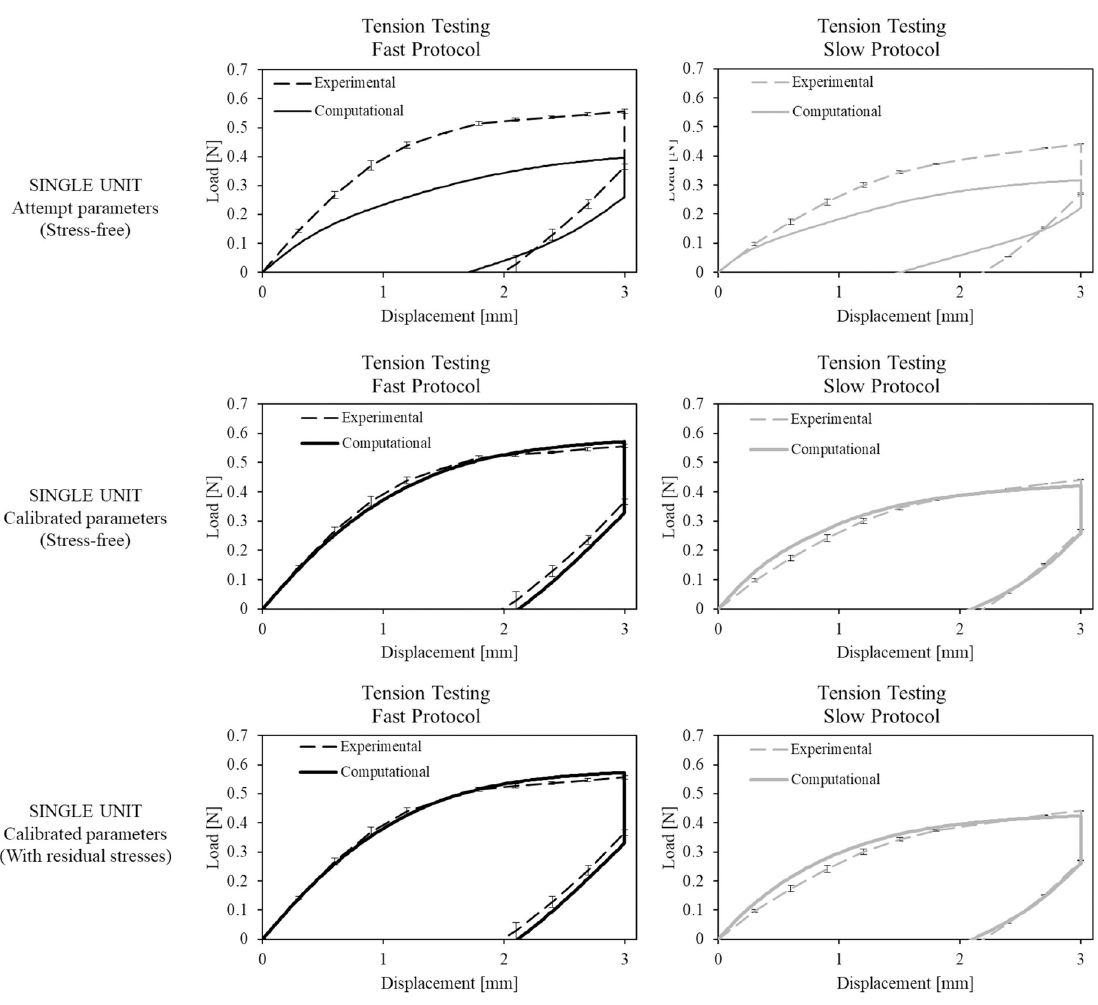
Fig 5. Comparison between experimental data of tension testing with “fast” and “slow” protocols and computational results obtained: i) at the beginning (upper part) and ii) at the end (central part) of the material parameter tuning process, using a stress-free single unit model; iii) at the end of the material parameter tuning process (lower part), using the single unit with residual stress. Error bars in the experimental curves indicate the maximum and minimum experimental value with respect to the mean value at the corresponding